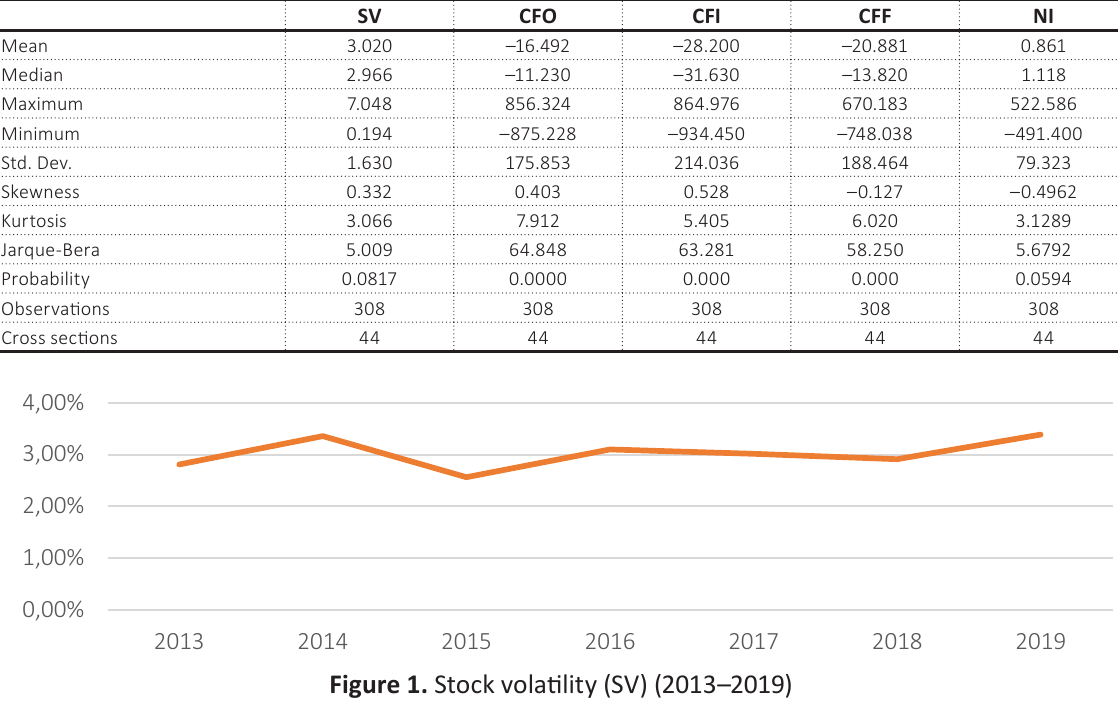
Figure 1. Stock volatility (SV)